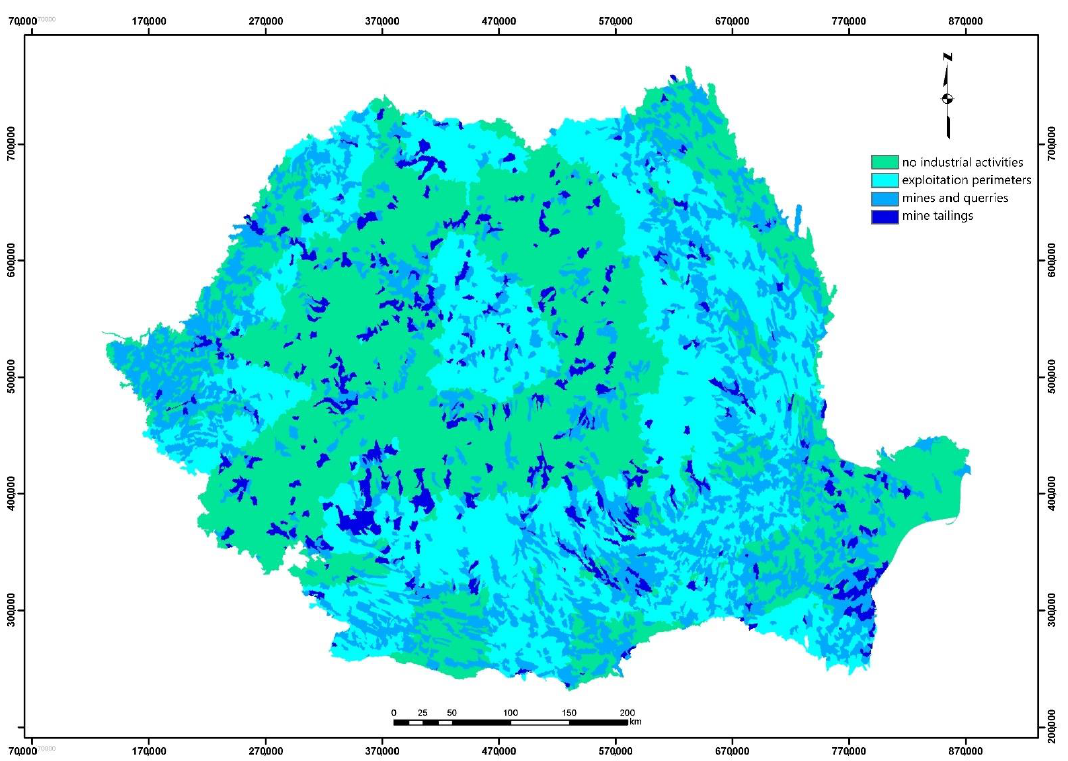
Figure 6. Initial processing of input data: industrial activity.